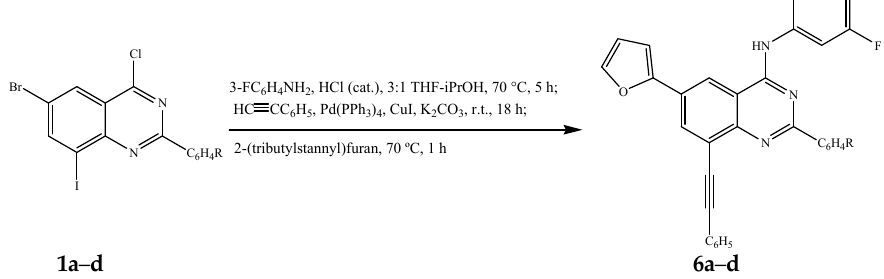
Table 5. Percentage yield of compounds 6a – d .